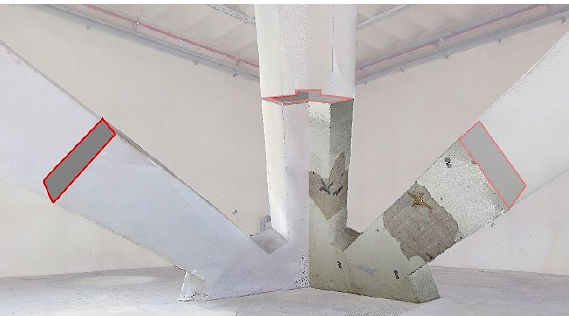
Figure 9. (a) Photogrammetric model of the basement; (b) Mesh-to-NURBS models and objects related to diagnostic